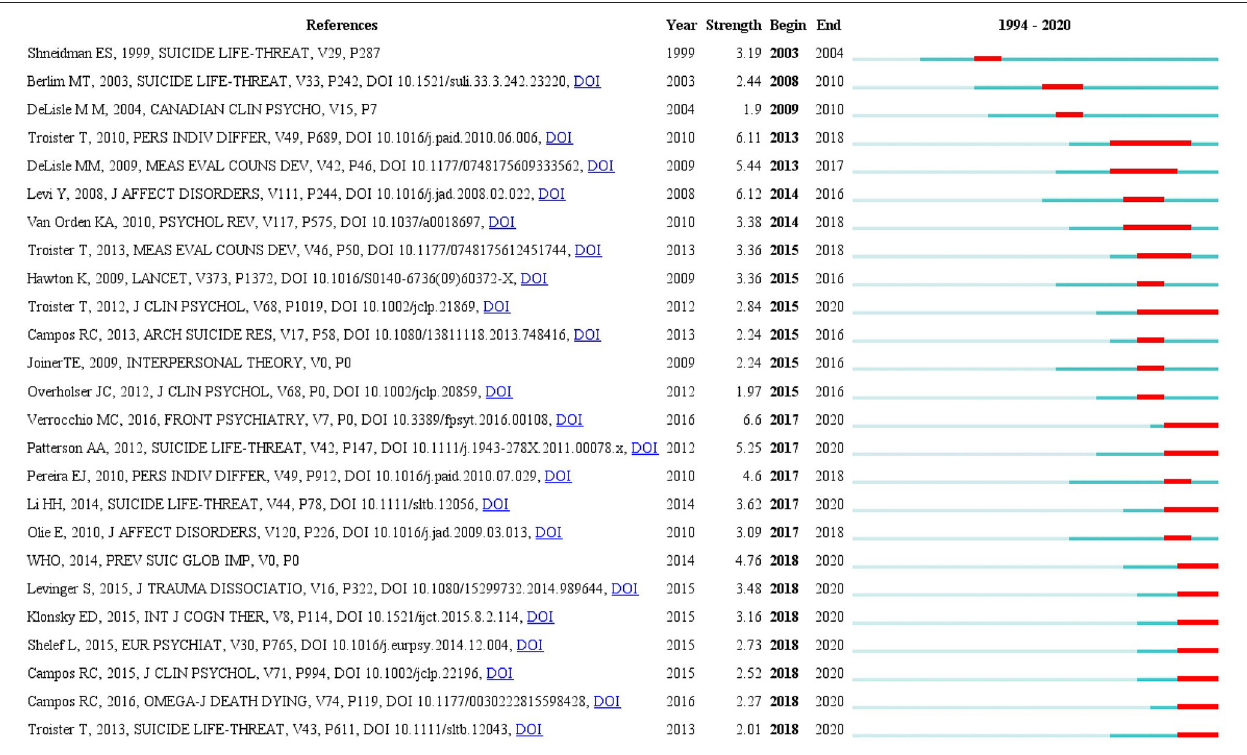
FIGURE 6 | The 25 burst references related to psychache research in the suicidology field between 1994 and